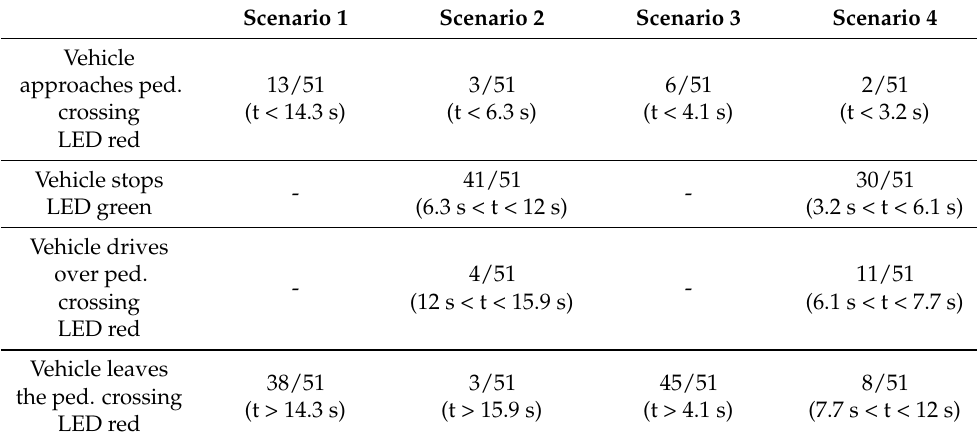
Table 1. Subjects clustered according to when the decision to cross was made 1 .